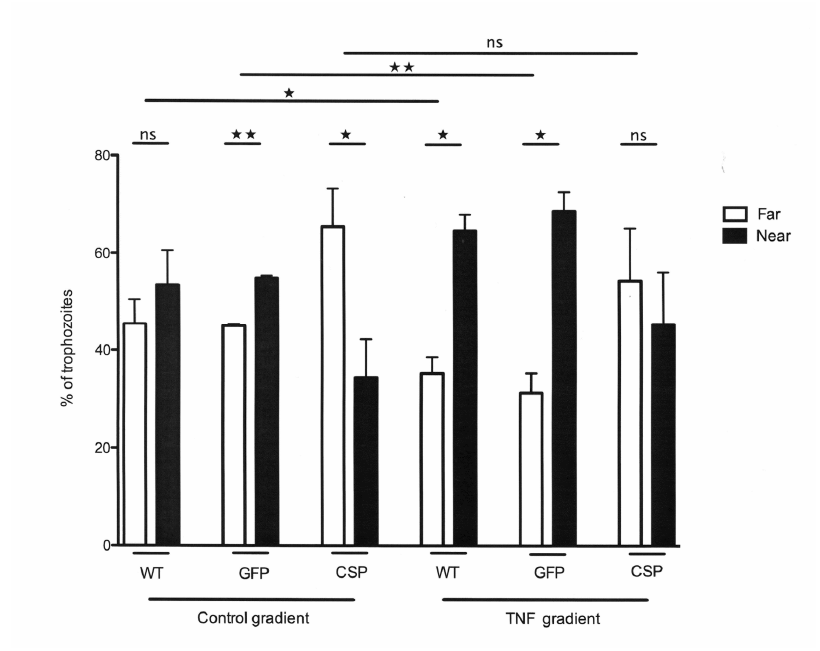
the absence of chemoattractant, WT trophozoites were evenly distributed along the coverslip (p=0.531) (Figure 5). When TNF was injected into the agarose slice, trophozoites were significantly more abundant near the source of TNF when WT (p=0.042) and GFP (p=0.005) strains were tested. In contrast, similar numbers of CSP-AS trophozoites were located near to or far from the TNF source (p=0.249), indi- cating that most of these cells did not react to the pres- ence of TNF. These results suggest that CSP is involved in TNF chemotaxis in trophozoites.